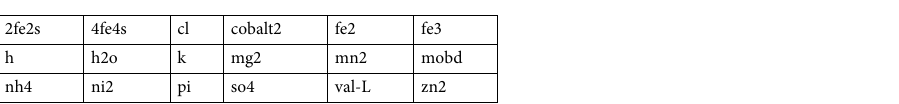
Table 2. Tabulation of model-specific names of the (cytosolic) coefficients in the biomass equation of iJO1366 25 associated with numerically unbounded multipliers σ , thus allowing RAMP to predict gene essentiality identical to that of standard